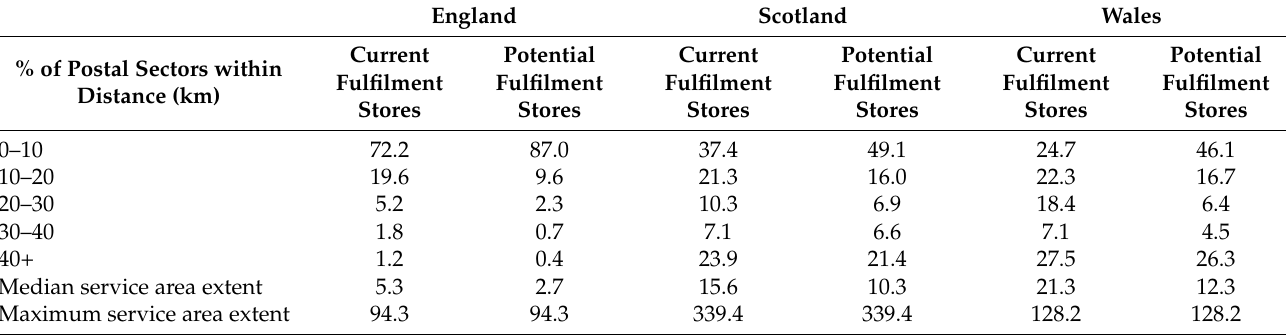
Table 5. Summary of the distances to the nearest fulfilment store on a store-by-store